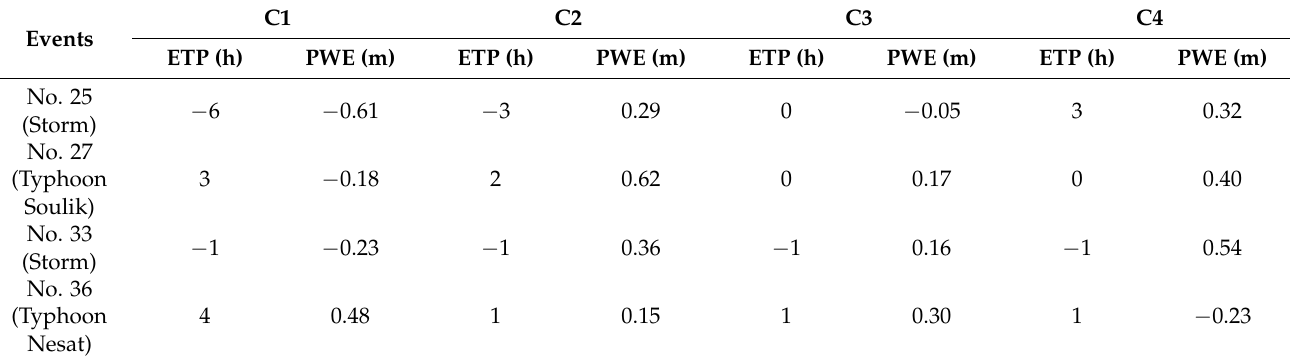
Table 5. Model test performances of river stage forecasting using SVR with four input combinations.